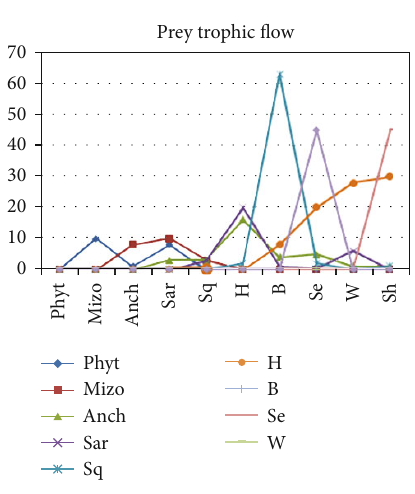
Figure 6: Prey trophic fl ow.